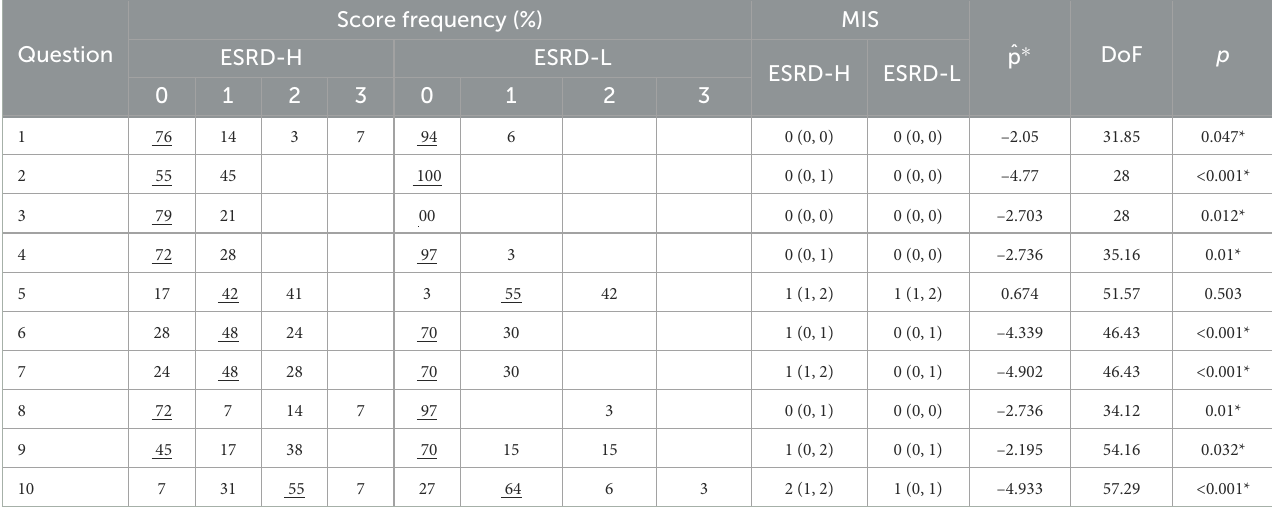
TABLE 2 The description and comparison of MIS answers in both subject groups.